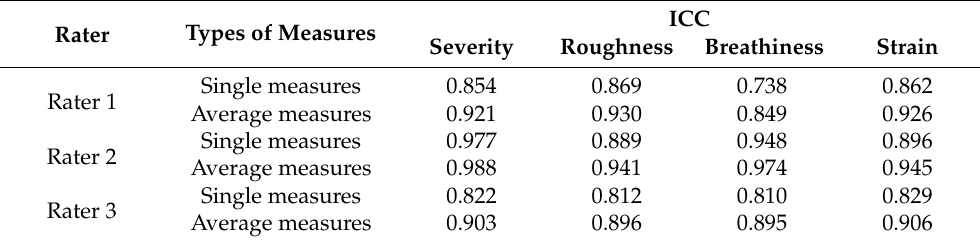
Table 3. Intra-rater reliability of the perceptual analysis ( p < 0.001 for all